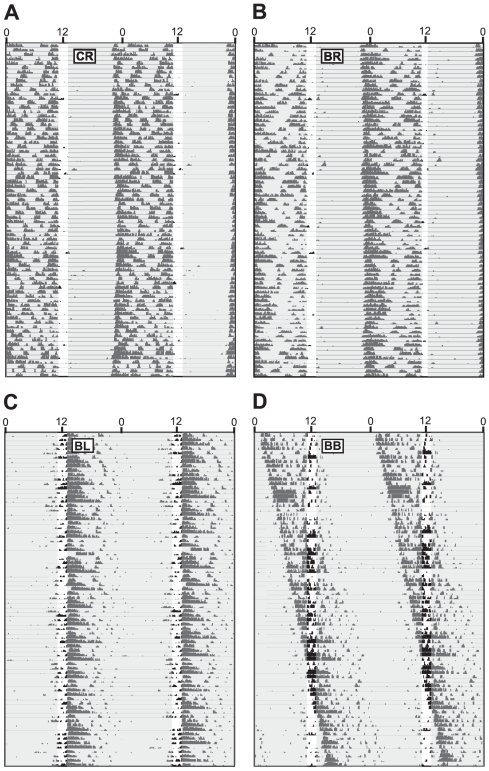
Representative double-plotted locomotor activity records of Syrian hamsters in experiment 5.Clock time is indicated on the horizontal axis along the top of each actogram. Lights on/off are indicated by light and shaded areas of the actogram. Hamsters were subjected to the following occlusion treatments for 38 weeks: A a clear lens over the right eye (CR), B an occluder over the right eye (BR), C an occluder over the left eye (BL), or D occluders over both eyes (BB).